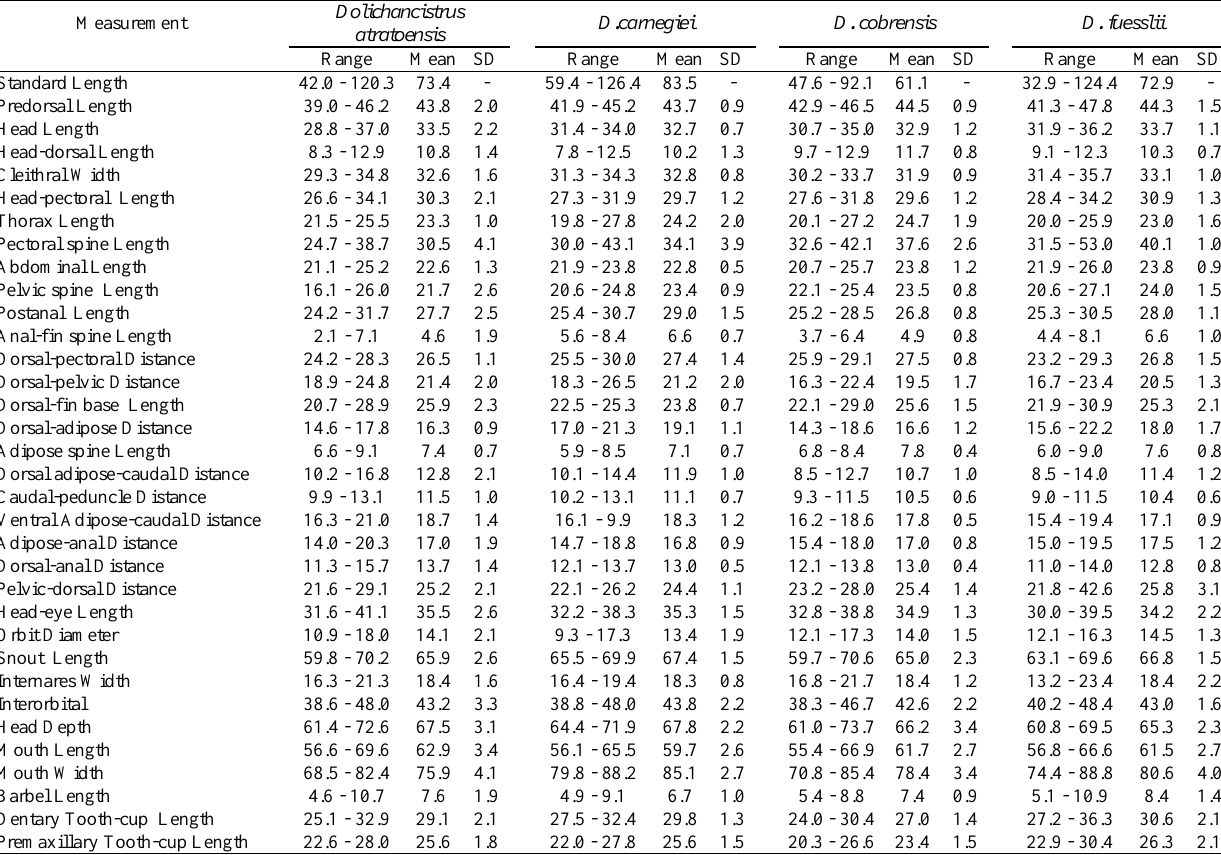
Distribution. Dolichancistrus atratoensis is known from southeastern tributaries of the río Atrato in northern Colombia along with the río Cubarradó, a small Pacific versant system draining a portion of the southern slope of the Serranía de Baudó in western Colombia (Fig. 2). Table 1. Morphometric data for Dolichancistrus atratoensis (n = 14), D. carnegiei (n = 22), D. cobrensis (n= 27) and D. fuesslii (n= 41). Landmarks follow Armbruster (2003). Standard deviation designated as SD. Dolichancistrus Measurement